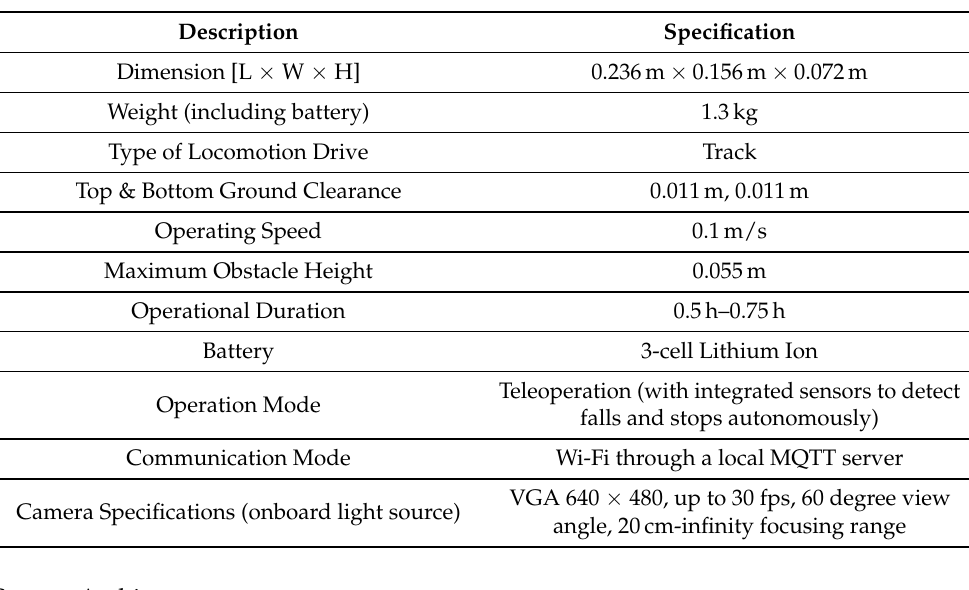
Table 2. Technical specifications of the Falcon robot.